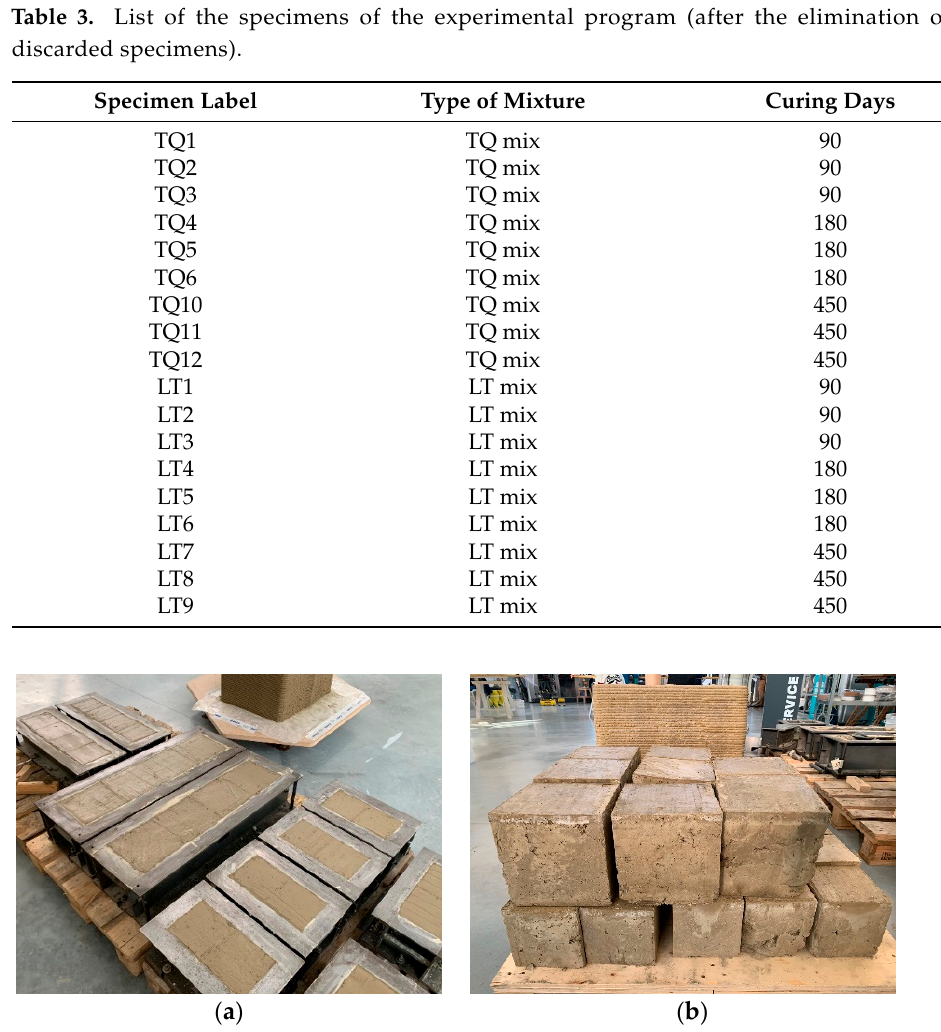
Figure 2. Preparation of the specimens: ( a ) the specimens after casting in the formworks; ( b ) appearance of the specimens upon removal of the formworks (before the selection that led to the exclusion of some specimens).